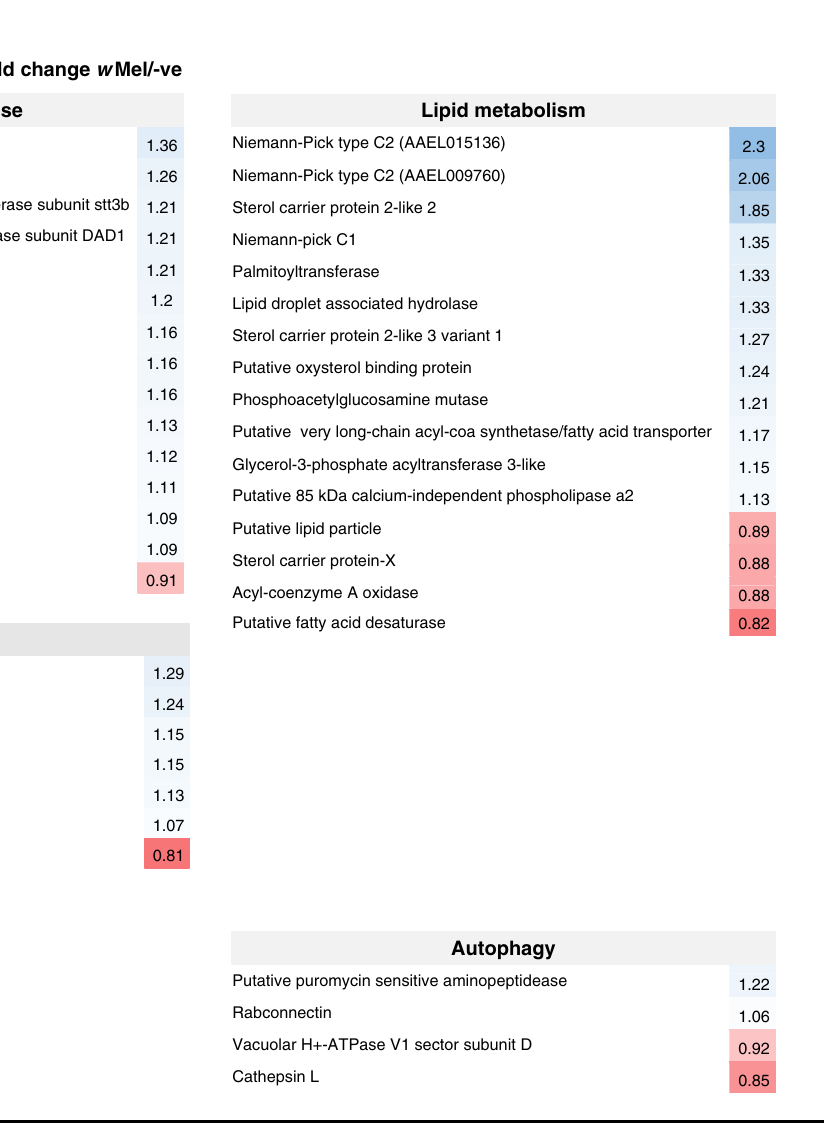
Table 2 Differentially expressed proteins with roles in the unfolded protein response, vesicular traf fi cking, lipid metabolism and autophagy in w Mel-infected vs. wt Aedes aegypti